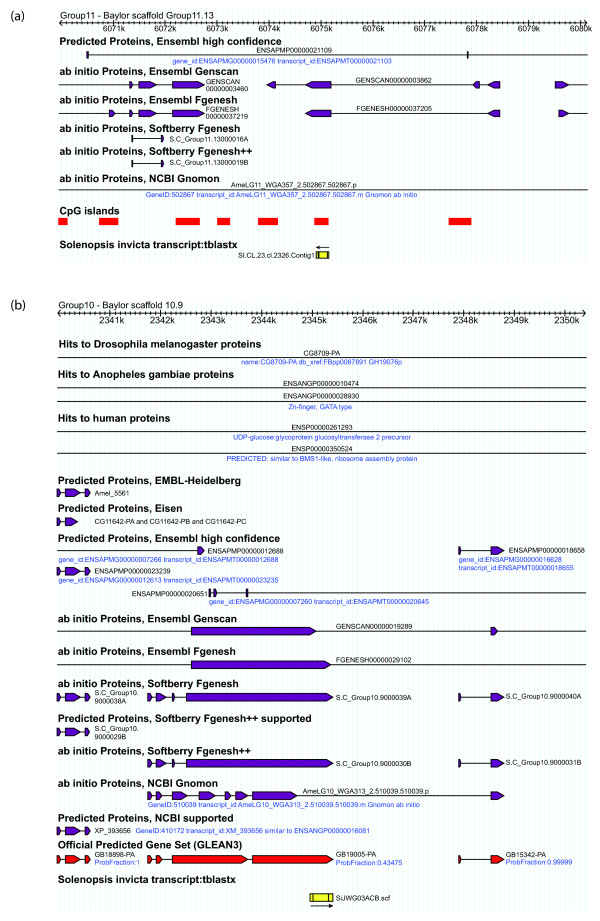
Examples of two candidate Hymenoptera-specific genes. (a) Fire ant sequence SI.CL.23.cl.2326.Contig1 matches an ab intio predicted honey bee gene that has no homology to any sequences in the public databases. The predicted gene was not included in the Honey Bee Official Gene Set. (b) Fire ant assembled sequence SiJWG03ACB.scf is the first EST evidence for the ab initio predicted honey bee gene GB19005-PA. Fire ant sequences are depicted as yellow boxes. Orientation (5' to 3') is indicated by an arrow. Predicted honey bee genes are depicted in purple; official Gene Set genes are shown in red. Images are based on output from Beebase (see Materials and methods).